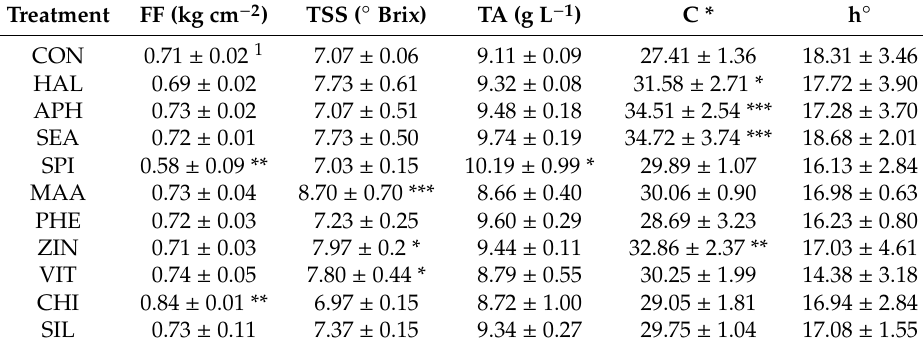
Table 10. Fruit quality traits (FF—firmness; TSS—total soluble solids; TA—titratable acidity and color parameters: C*—chroma; h ◦ —hue angle) as a ff ected by biostimulant products.